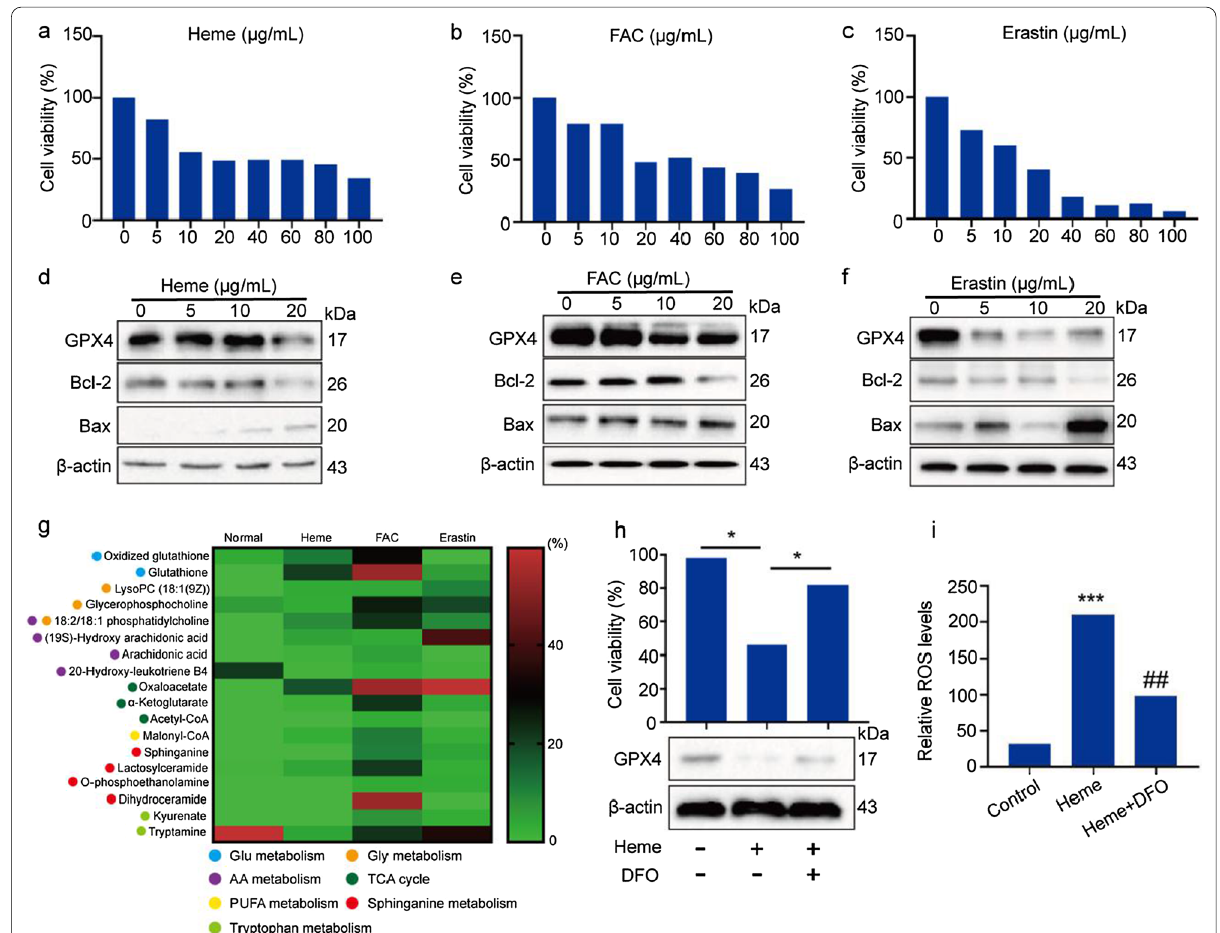
pretreatment for 1 h (upper), and the protein levels of GPX4 in HNPCs were measured after 20 μg/mL heme treatment for 24 h with or without 30 μg/mL DFO pretreatment for 1 h (lower). h Identification of ROS and ferroptosis-related metabolites in HNPCs after treatment with 20 μg/mL heme, 20 μg/mL FAC, and 10 μg/mL erastin for 24 h using high-resolution MALDI-TOF MS. i ROS levels in HNPCs after 20 μg/mL heme treatment for 24 h with or without 30 μg/mL DFO pretreatment for 1 h. The data were analyzed with GraphPad Prism 5.02 software. *P < 0.05, **P <